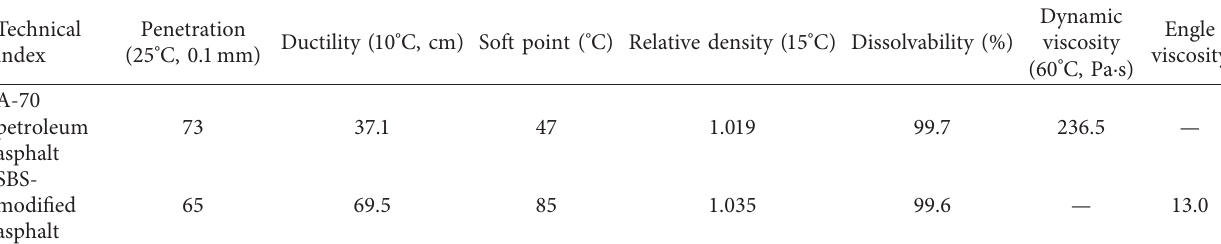
Table 1: Technical properties of the asphalt used in this